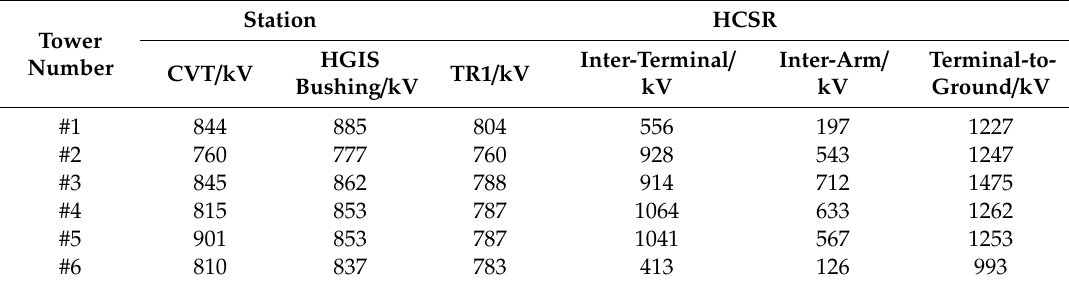
Figure 9. Inter-terminal and inter-arm overvoltage of the HCSR. Table 14. Overvoltage of the equipment in current limiting state.